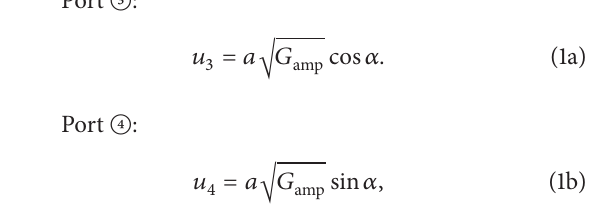
A and array B was computed for comparison. The simulated results for three typical polarizations are shown in Figure